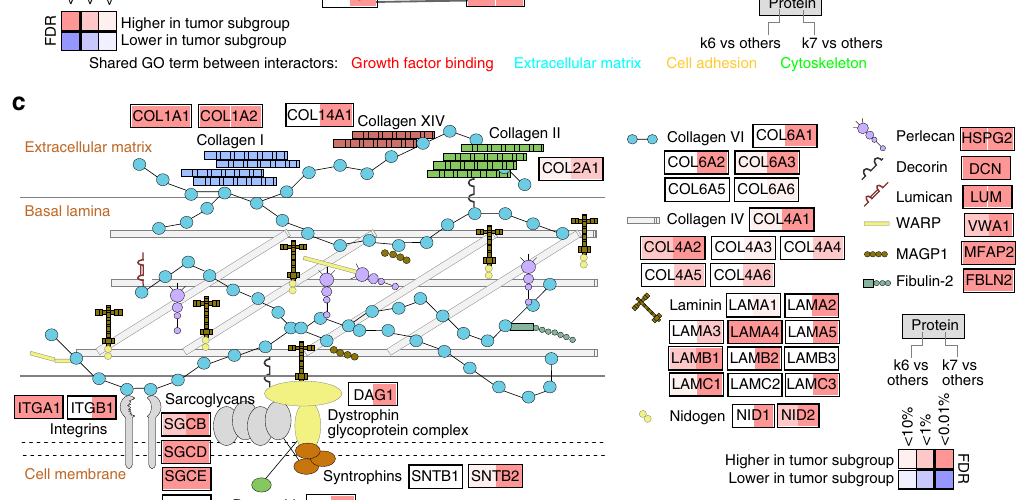
PPP1R12ASORBS2VCL COL14A1 RRASRASIP1 SYNPO SOD3FLNA DAG1PPP1R12B SEPT10 TRIOBPMYO1C FBLN5 MRVI1 PDE5A othersProtein Cytoskeletonk7 vs othersk6 vs Growth factor binding Extracellular matrix Cell adhesion